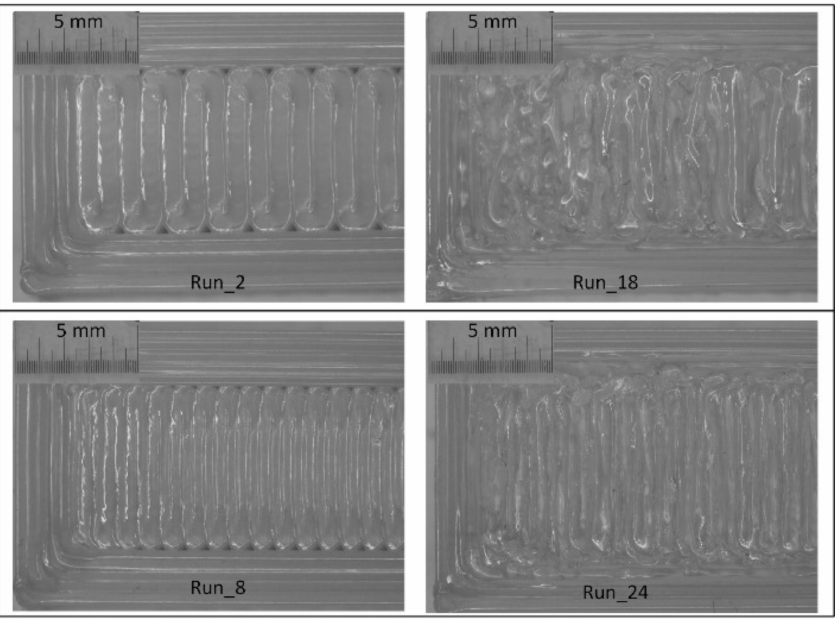
Figure 10. Effect of air gap on the surface quality of